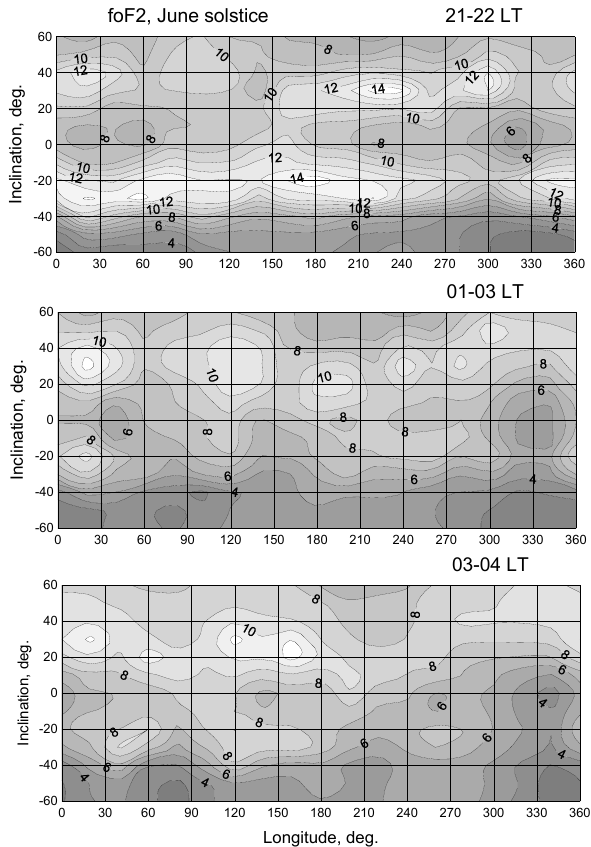
Fig. 5. The same as in Fig. 2 but for the June solstice.